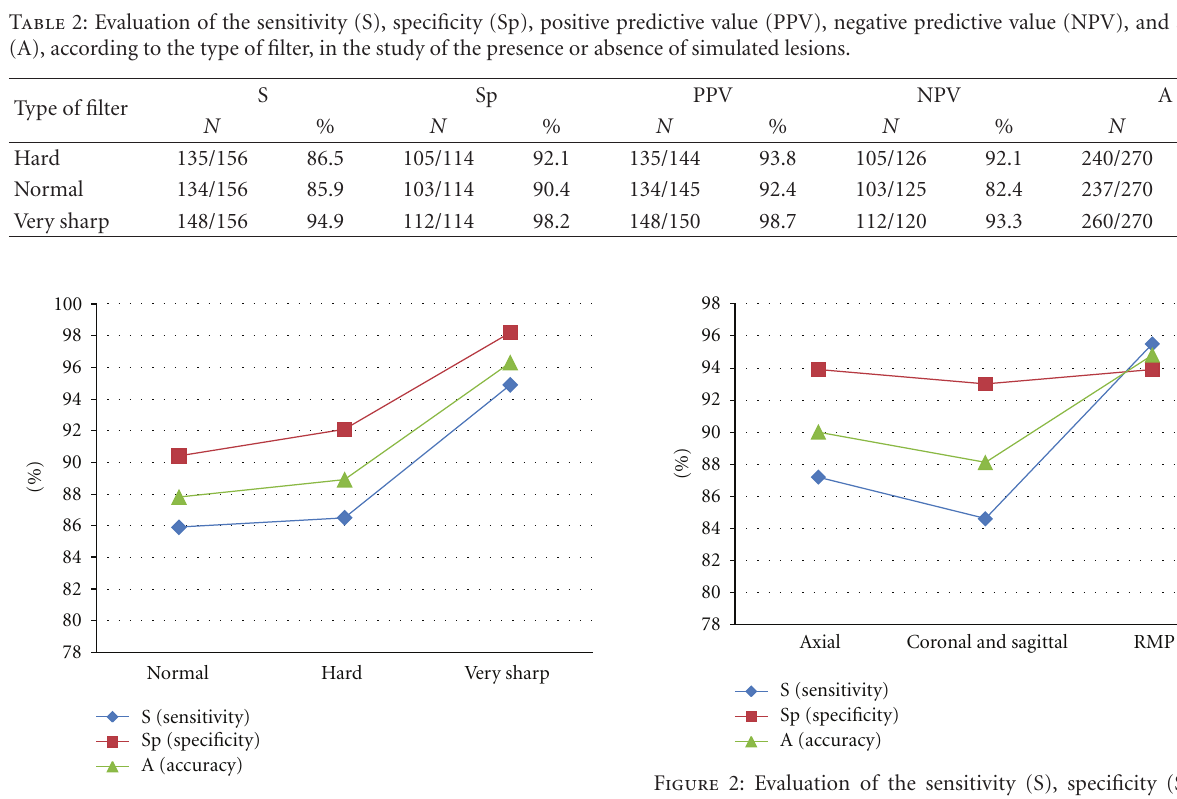
Figure 1: Evaluation of the sensitivity (S), specificity (Sp), and accuracy (A), according to the type of filter, in the study of the presence or absence of simulated lesions.